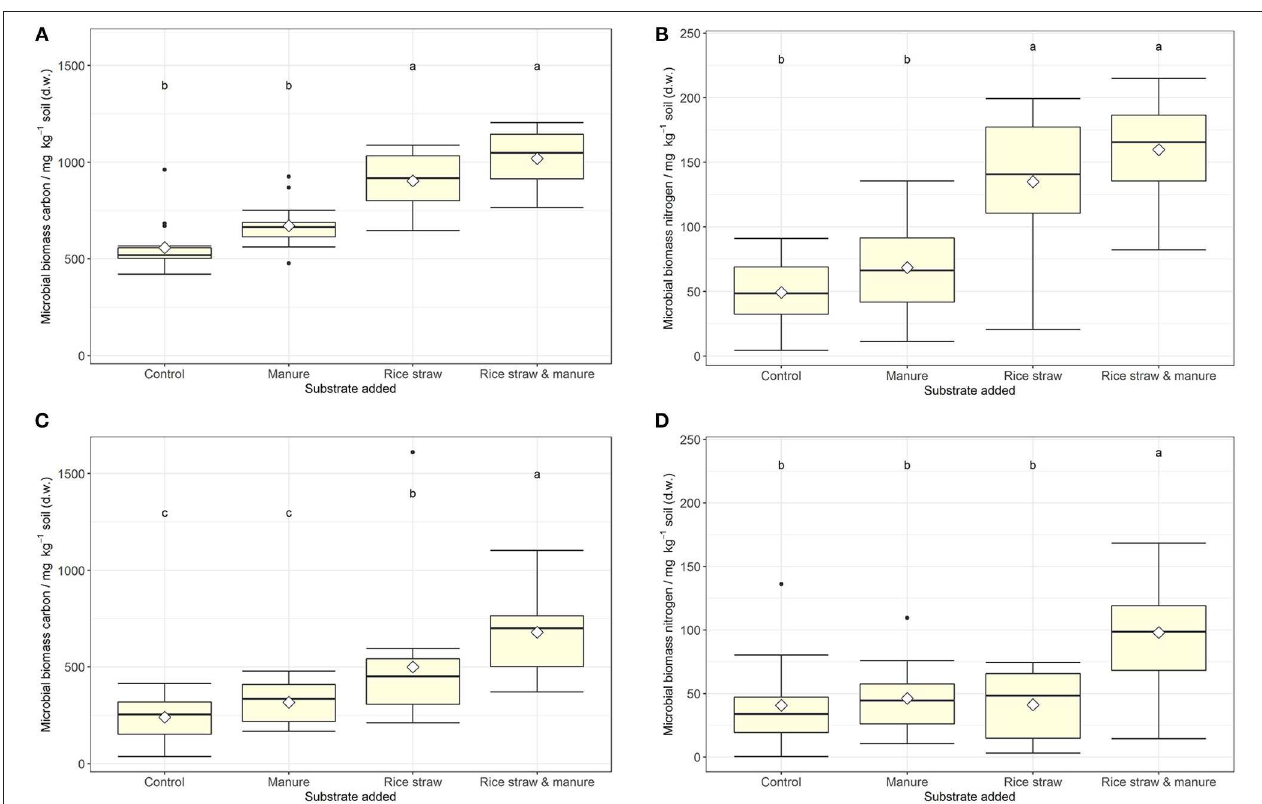
FIGURE 2 | (A–D) Microbial biomass C and N (mg kg − 1 soil) at the end of the incubation for soil A (upper panel, A,B ) and soil B (lower panel, C,D ) after manure, rice straw or manure plus rice straw addition. Diamonds indicate the mean and different letters indicate significant differences at p < 0.05 (ANOVA with model simplification; n = 4). Substrate addition was the only consistent significant effect on microbial biomass C and N in both soils. Salt addition had a significant reducing effect on soil microbial C in soil A at 50% water holding capacity